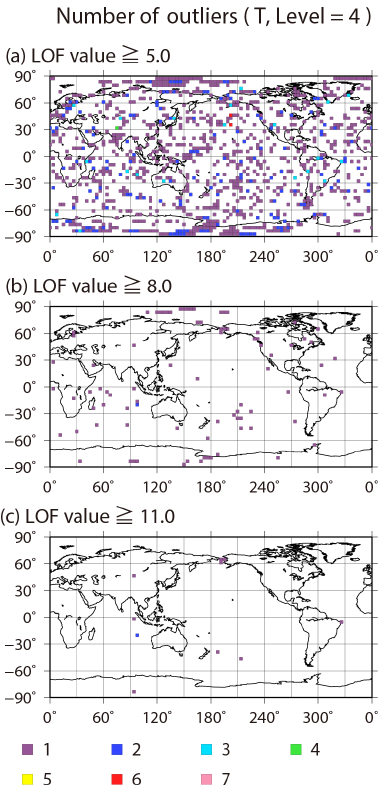
Figure 6. Spatial distributions of the number of outliers for background temperature at the fourth model level ( ∼ 500hPa) at 06:00UTC on 22 February for LOF thresholds of (a) 5.0, (b) 8.0, and (c) 11.0.